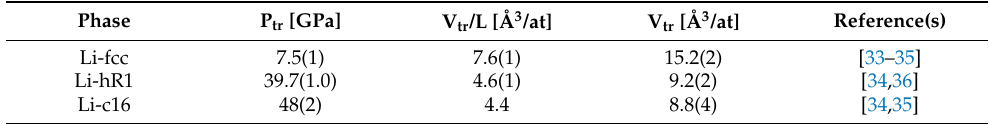
Table 1. Columns from left to right: Name of polymorph, pressure of phase transition at 300 K, volume of phase transition divided by the principal quantum number L, volume of phase transition at 300 K, and